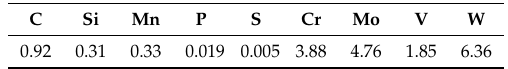
Table 3. The chemical composition of tool steel 1.3343 (wt